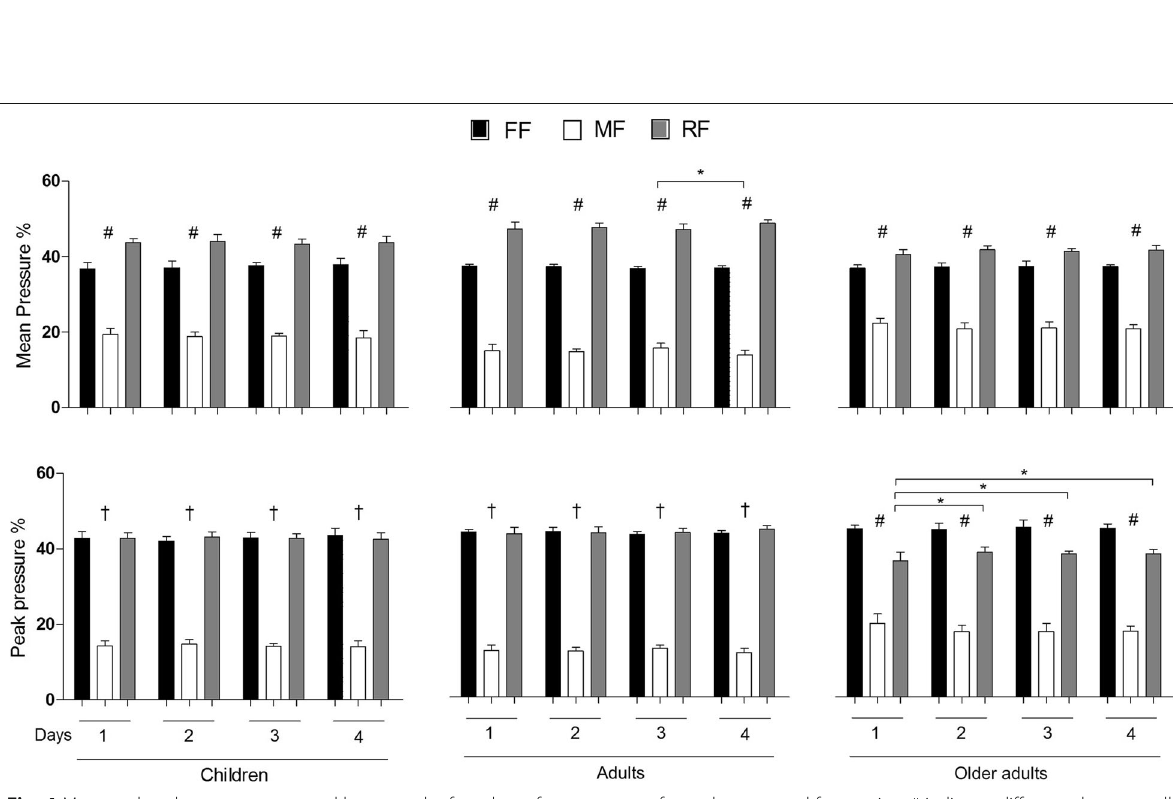
Fig. 4 Mean and peak pressure compared between the four days of measurement for each group and foot region. # indicates difference between all foot regions. † indicate difference in the rearfoot (RF) and forefoot (FF) compared to midfoot (MF) * indicates difference between the